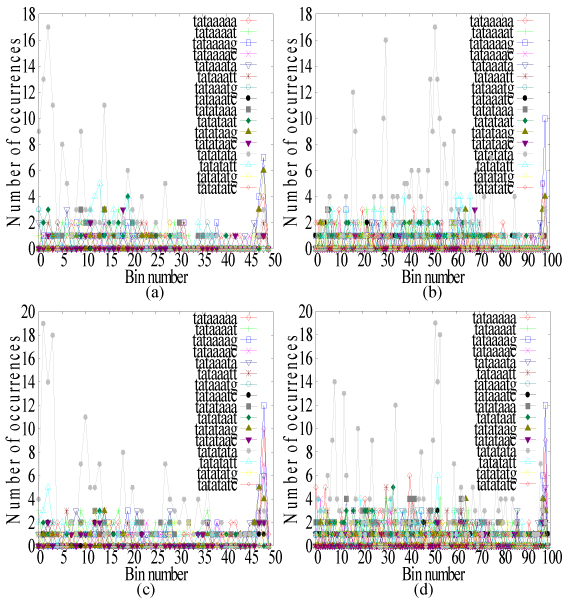
Frequency Distribution of sixteen TATA Box elements on promoters of housekeeping genes and tissue specific genes. Frequency distribution of sixteen TATA elements is observed on four data sets: (a)Shk1000 (b) Shk2000 (c)Sts1000 and (d)Sts2000. These four data sets represent 1000 bp long promoters of housekeeping genes, 2000 bp long promoters of housekeeping genes, 1000 bp long promoters of tissue specific genes and 2000 bp long promoters of tissue specific genes respectively. The frequency distribution of sixteen TATA elements on housekeeping genes is very similar with their frequency distribution on tissue specific genes by comparing Figure 3(a) with Figure 3(c) and comparing Figure 3(b) with Figure 3(d).